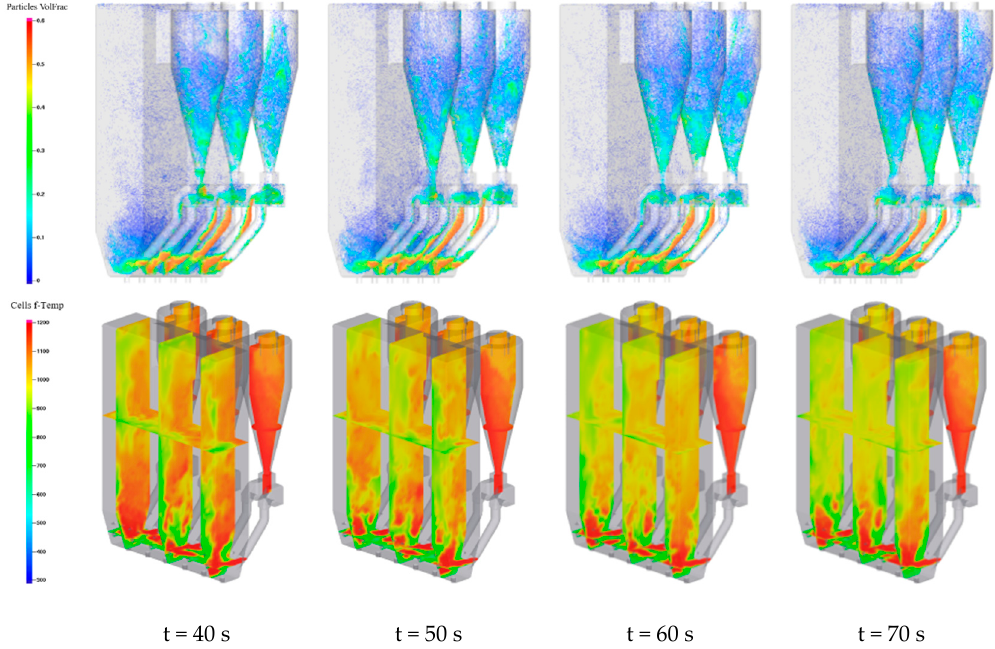
Figure 20. Distribution of flow field and temperature field during load up process (30~70 s).